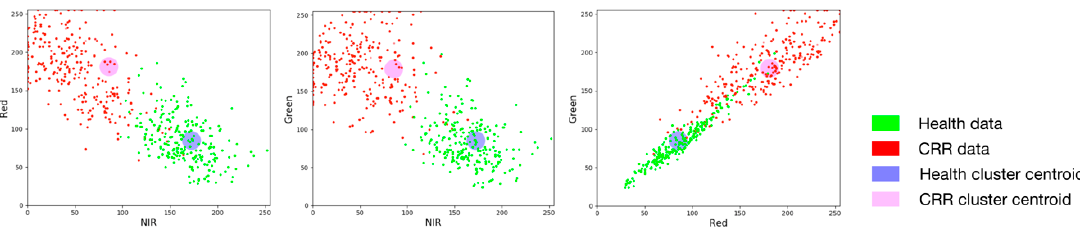
Figure 6. The relationships between bands in a sampled dataset along with k-means cluster centroids.